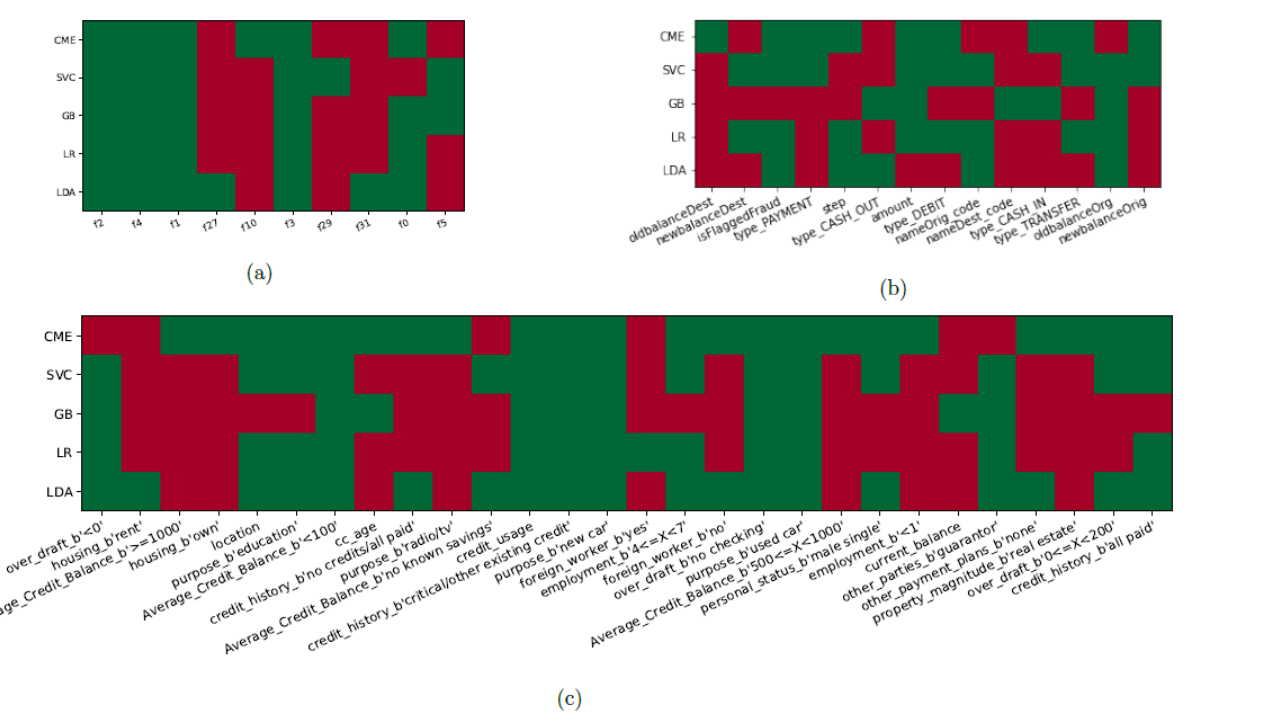
Figure 4. Results of IVI algorithm for each ML technique in the synthetic dataset ( a ), in the German Credit Dataset ( b ), and in the PaySim ( c ). In rows are the different ML techniques: covariance multiplication estimator (CME), support vector machine classification (SVC), gradient boosting (GB), linear regression (LR), and linear discriminant analysis (LDA). In columns are the different features as defined previously. Green color represents scenarios where feature was identified as relevant. Red color represents features not identified as relevant during the analysis. The threshold for determining relevance is defined by MIFF filter (at least in two